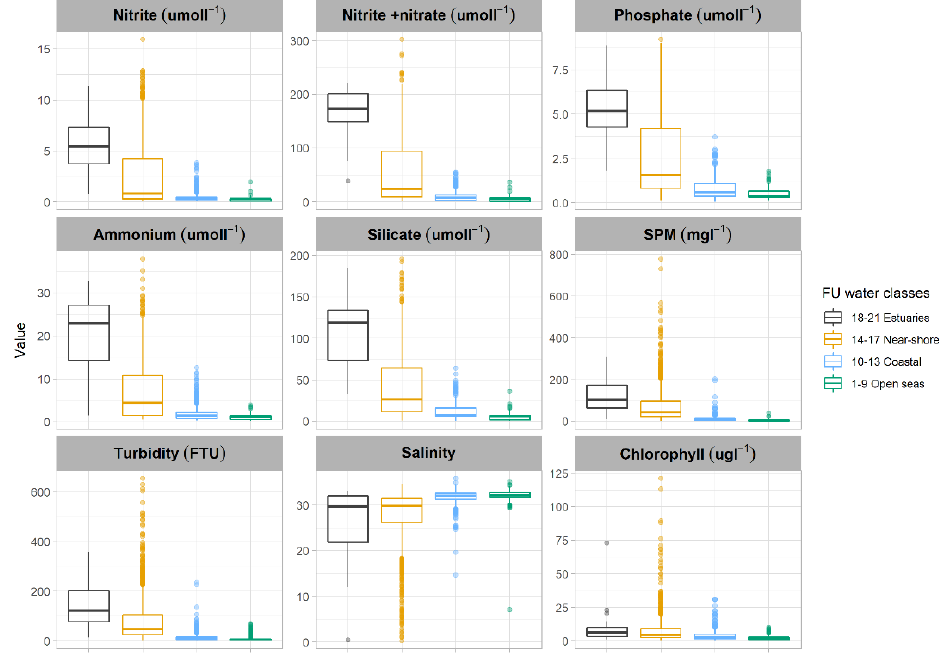
Figure 11. Whisker boxplots showing quartile distribution of water nutrients, chlorophyll-a, salinity and SPM in four Forel – Ule Citclops water classes: 1. Estuaries, 2. Near-Shore, 3. Coastal and 4. Open Seas.